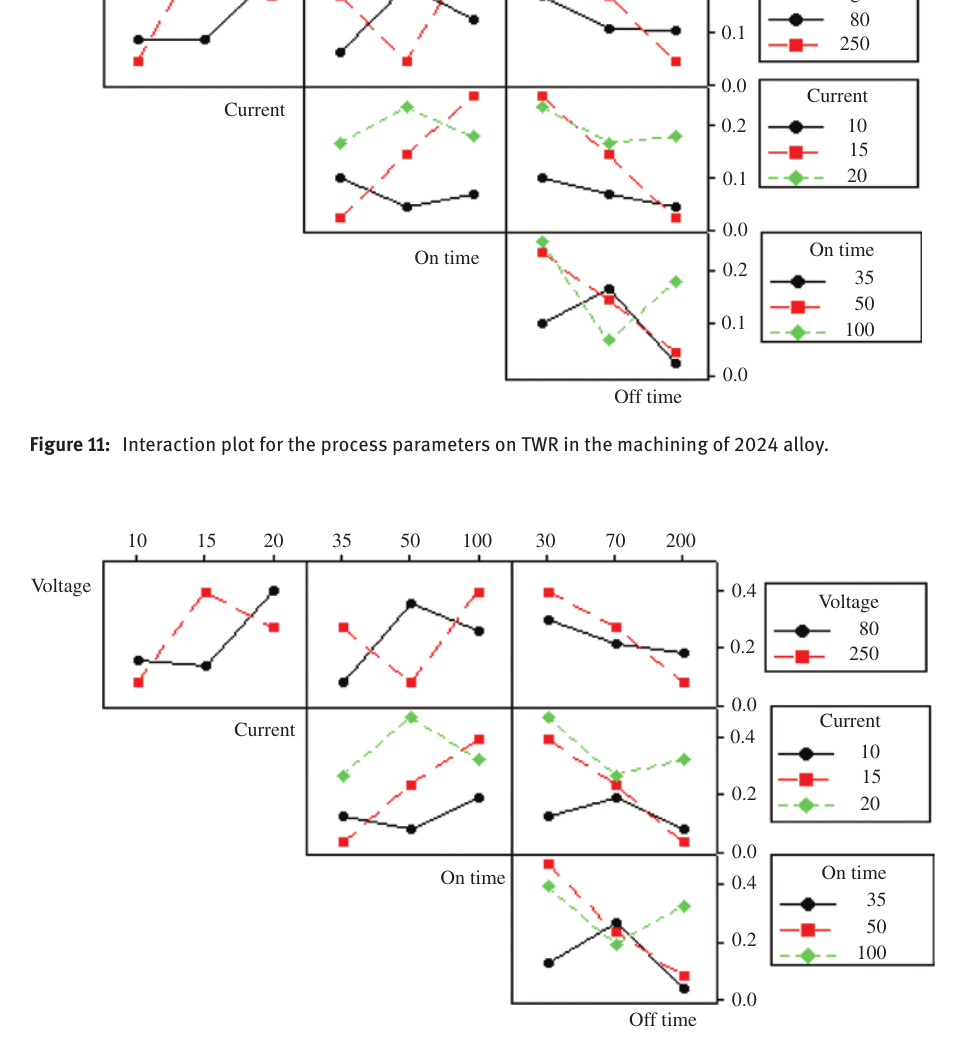
Figure 12: Interaction plot for the process parameters on TWR in the machining of Al/5%Al